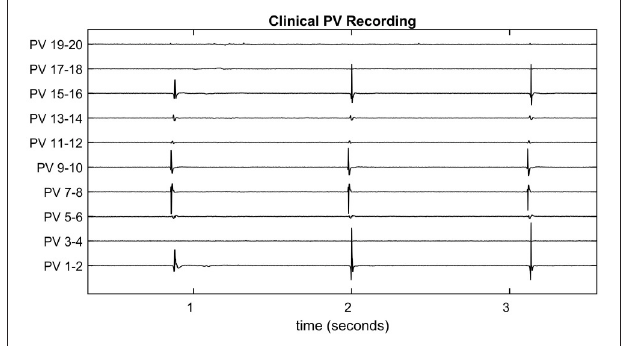
FIGURE 1 | Clinical pulmonary vein recording. The pulmonary vein recording of a patient with atrial fibrillation during pulmonary vein isolation therapy. Spiking indicates electrical activity as the action potential propagates through the recording catheter. Since the pulmonary vein is not a perfect cylinder, not all electrodes make a good contact. For example, Channels 3-4, 17-18, and 19-20 show no spiking activity for this reason. These are referred to as missing channels throughout the